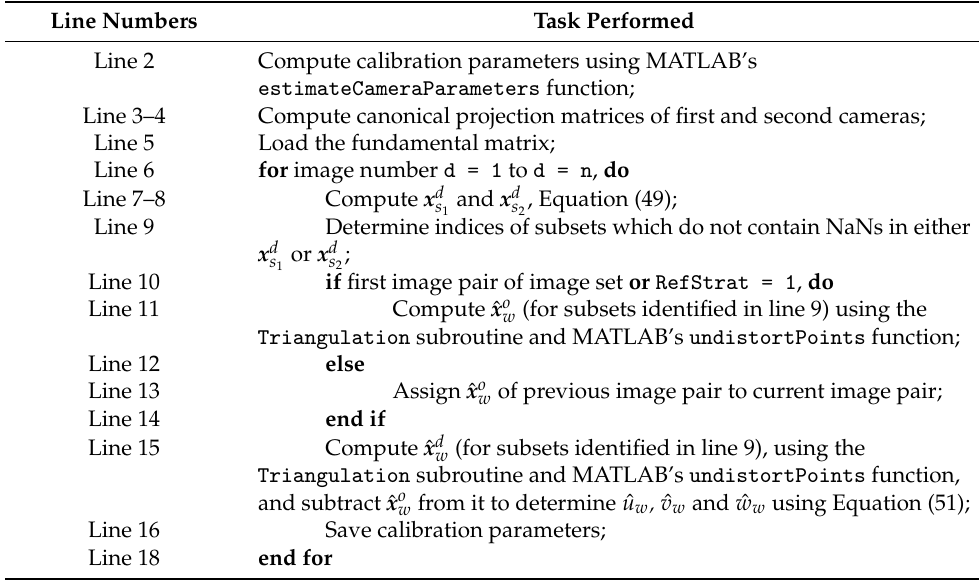
Table 13. CSTrans algorithm summary.